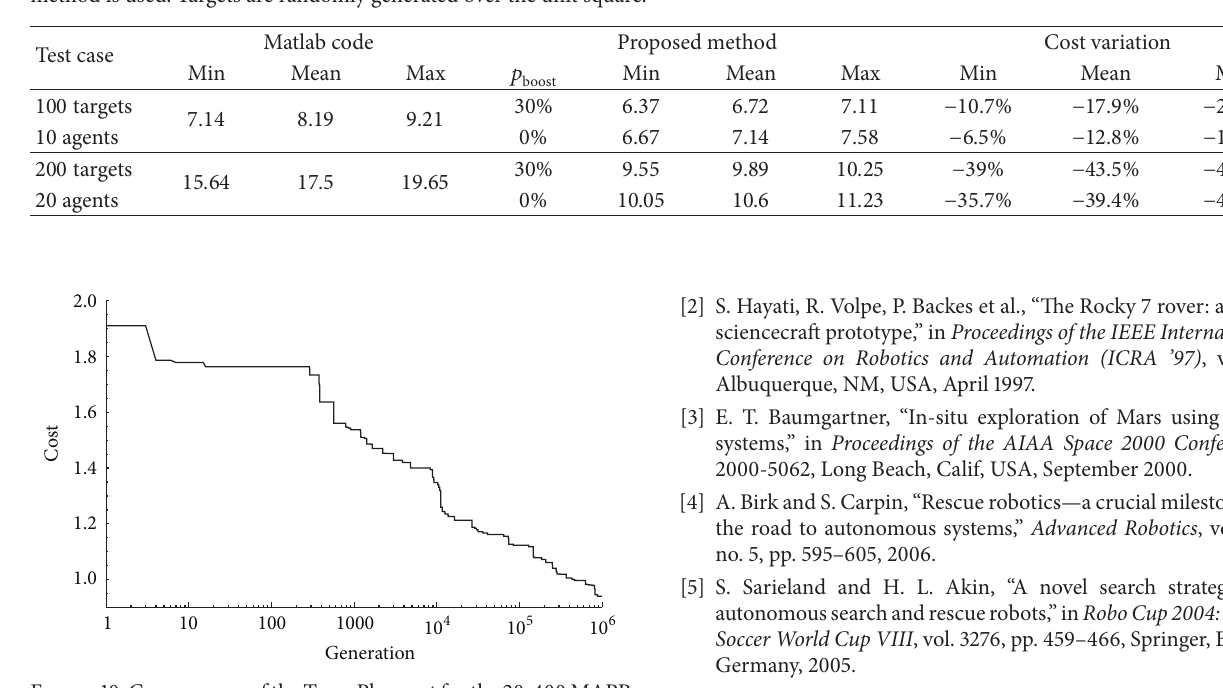
= 2 and the greedy initialization min